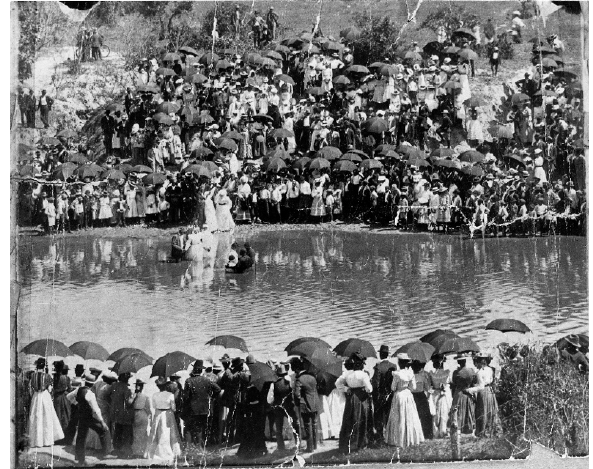
Figure 5. African Americans in Texas gather to witness a baptism in Buffalo Bayou near Houston, Texas in 1990. Photograph courtesy of Special Collections, University of Houston Libraries.